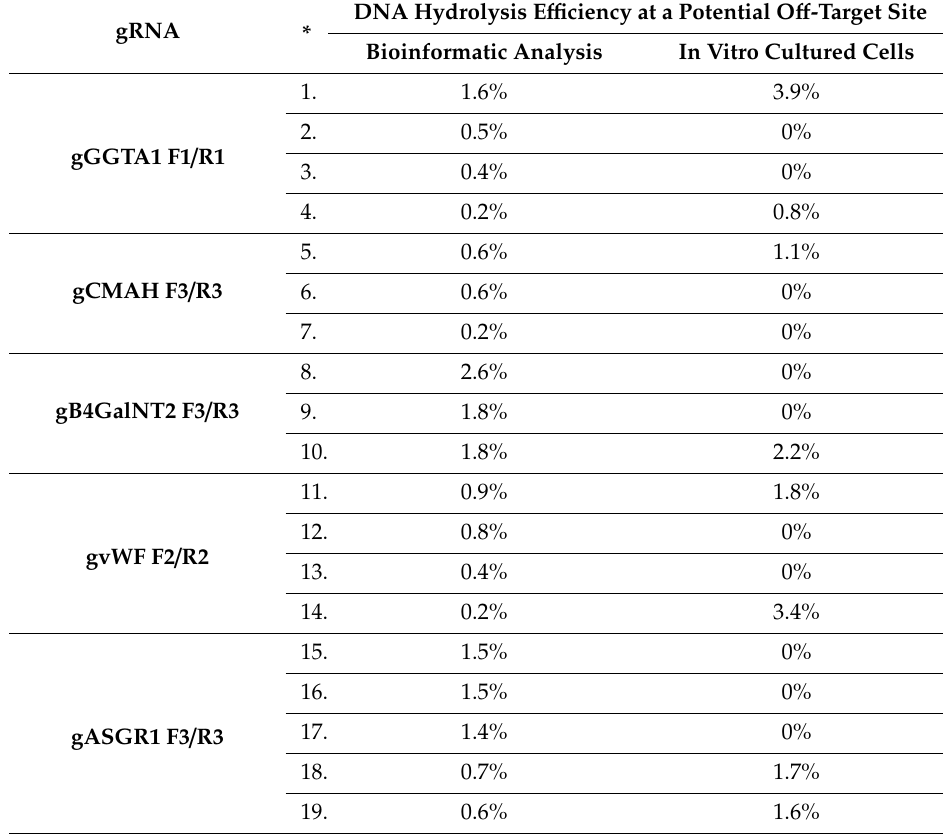
Table 4. Comparison of bioinformatic analysis with the results of laboratory analyses—analysis of the o ff -target sites